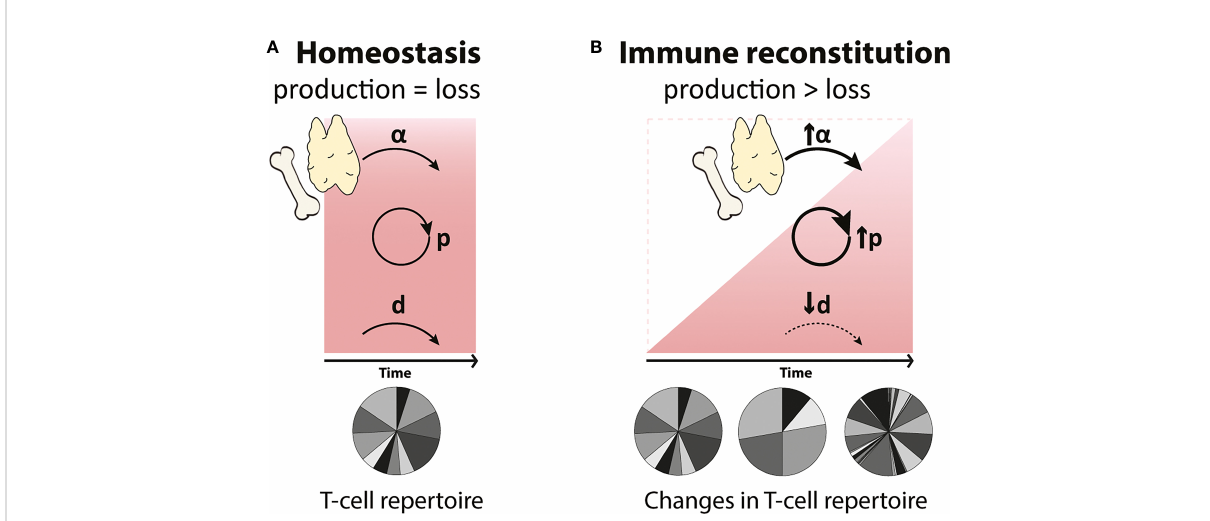
FIGURE 1 Possible compensatory mechanisms governing T-cell reconstitution during lymphopenia (A) In homeostasis, T-cell numbers (represented by the red square) are maintained at relatively constant levels by the balanced generation and loss of T cells. T cells are generated by thymic output ( a ) and by T-cell proliferation (p), and these processes are balanced by the loss of T cells (d) through cell death, maturation and migration. (B) During immune reconstitution (represented by the red triangle), changes in de novo production ( a ), proliferation (p) and loss (d) rates of T cells may occur to compensate for low T-cell numbers. Increased peripheral T-cell proliferation ( ↑ p) will lead to a faster reconstitution but may generate a more clonal T-cell repertoire. An increase in the de novo production of T cells by the thymus ( ↑ a ) will reduce the time to reconstitute and will result in a highly diverse T-cell pool. Finally, a decrease in T-cell loss ( ↓ d), e.g. longer cell lifespans, may help to accelerate T-cell reconstitution. We here investigated whether any of these possible homeostatic mechanisms occur in